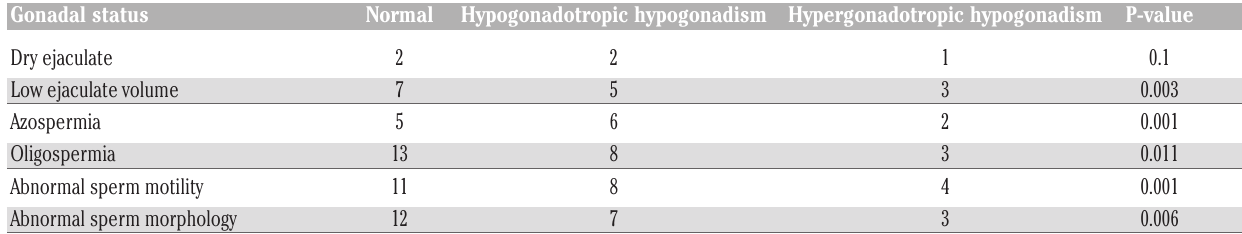
Table 3. The relationship between hypogonadism and sperm